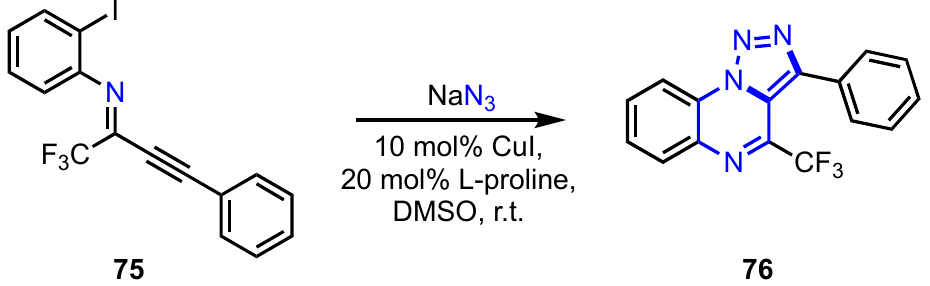
Scheme 19. Synthesis of 3-phenyl-4-(trifluoromethyl)-1,2,3-triazolo[1,5- a ]quinoxaline 76 from N-( o - haloaryl)alkynylimine 75 .